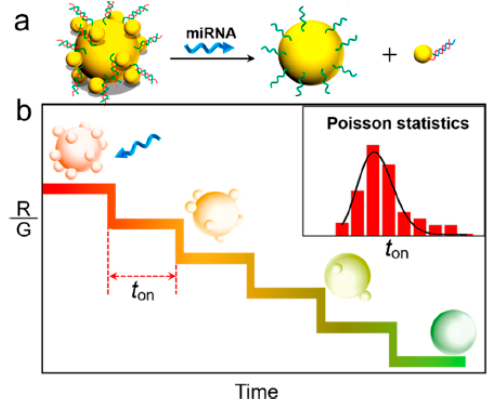
Figure 1. Schematic representation of a plasmon ruler for microRNA sensing. ( a ): Dissociation of smaller AuNPs from the larger AuNP induced by microRNA. ( b ): Detection principle. The dissociation of smaller AuNPs from the larger AuNP shifts the scattering wavelength. Reproduced from Ref. [50] with permission. Copyright 2018 American Chemical Society.